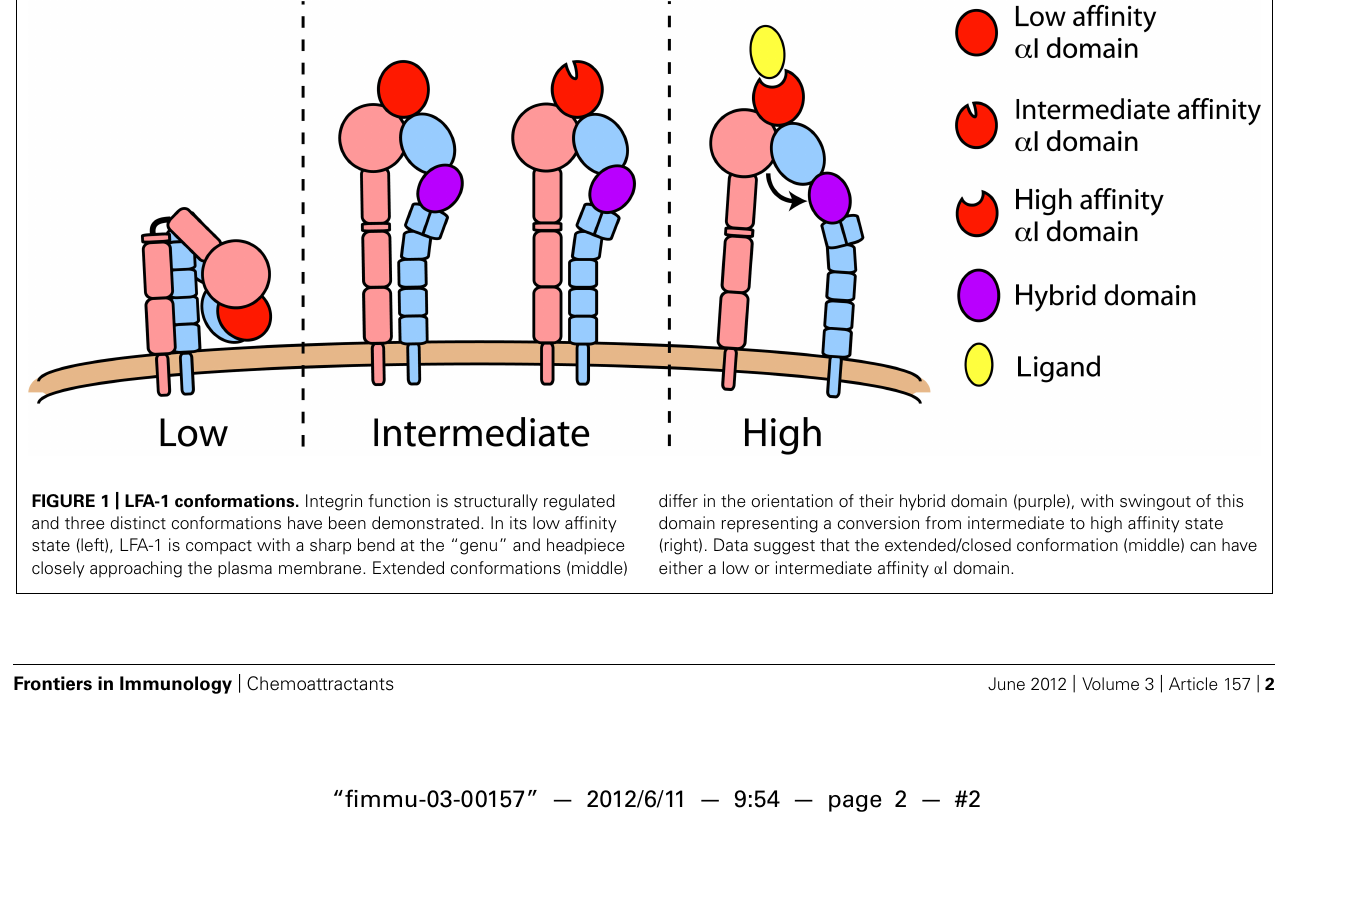
Frontiers in Immunology |